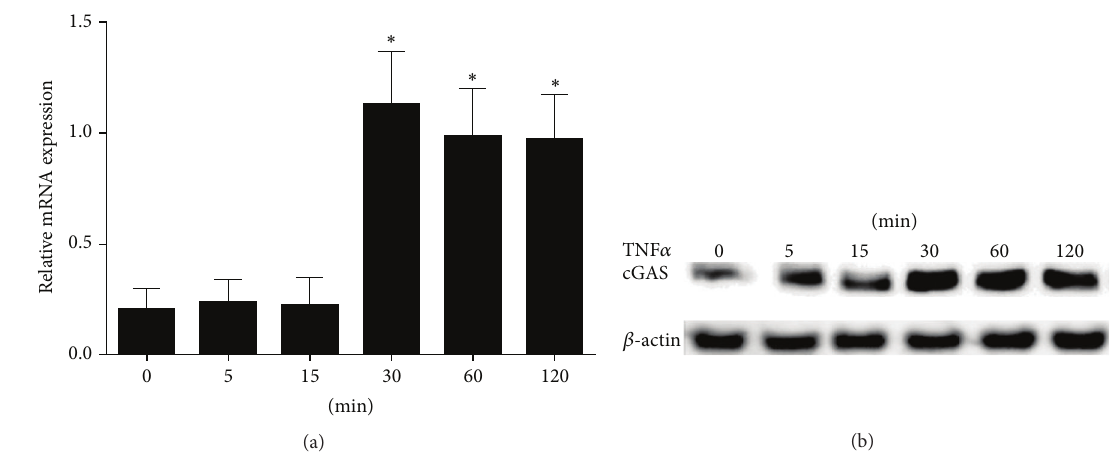
Figure 2: The expression of cGAS gene in rheumatoid arthritis (RA) fibroblast-like synoviocytes (FLS) was inhibited by tumor necrosis factor 𝛼 (TNF 𝛼 ) inflammatory stimulation. (a) cGAS mRNA was upregulated by TNF 𝛼 stimulation in a time-dependent manner. RA FLS (2 × 10 5 ) were cultured in 6-well plates and then treated with TNF 𝛼 (100ng/mL) for different times (0, 15, 30, 60, and 120 min). (b) The level of cGAS protein was determined by Western blot. Values are the mean and SEM (standard error of the mean). Results are representative of 3 independent experiments. ∗ 𝑃 < 0.01 versus 0 min.